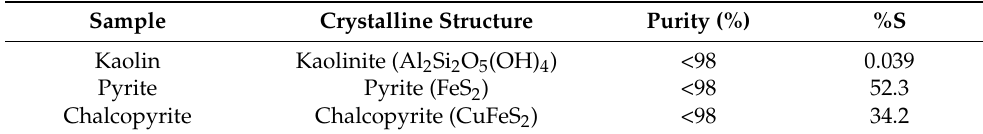
Table 1. Mineralogical and chemical composition of the